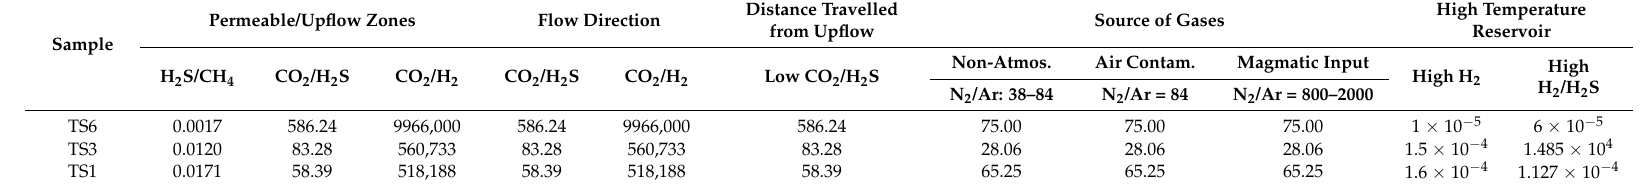
Table 9. Geoindicator analysis of gas fluid from dry-gas samples in order to identify the Tampomas fluid characteristics.